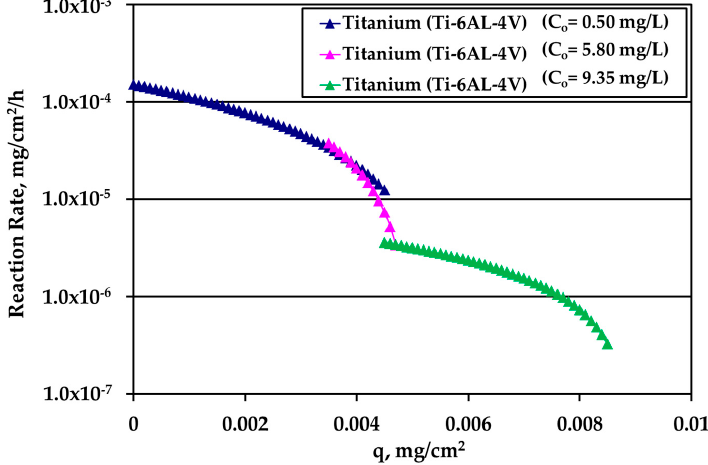
Figure 9. Reaction rate dependence on silver loading on titanium for various silver (bulk) concentration values.